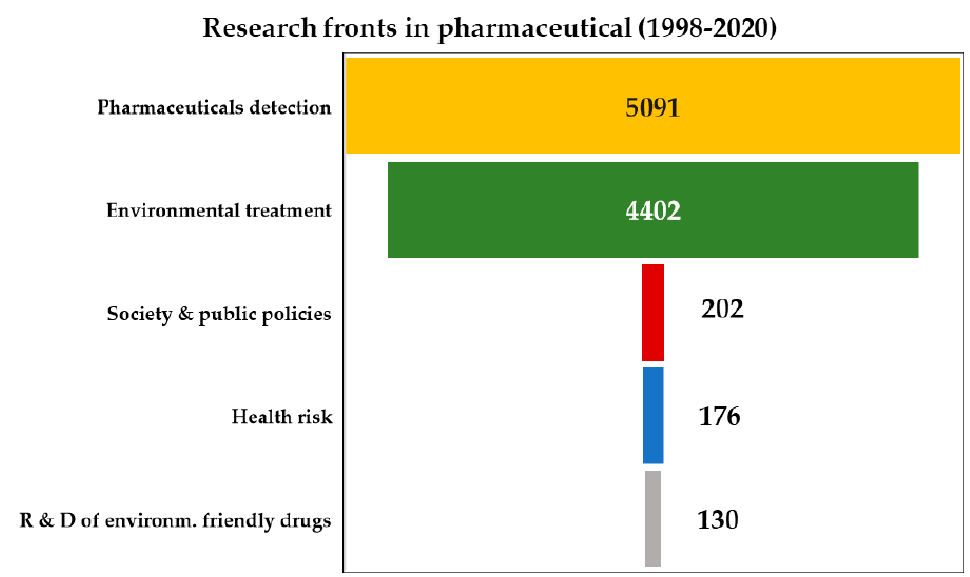
Figure 23. Number of scientific papers by pharmaceutical research fronts under study in Scopus according with the methodology used in Table 3. Data collected from 1998 to 2020. Table 6. Wastewater most well know regulations and their pharmaceutical approaches.